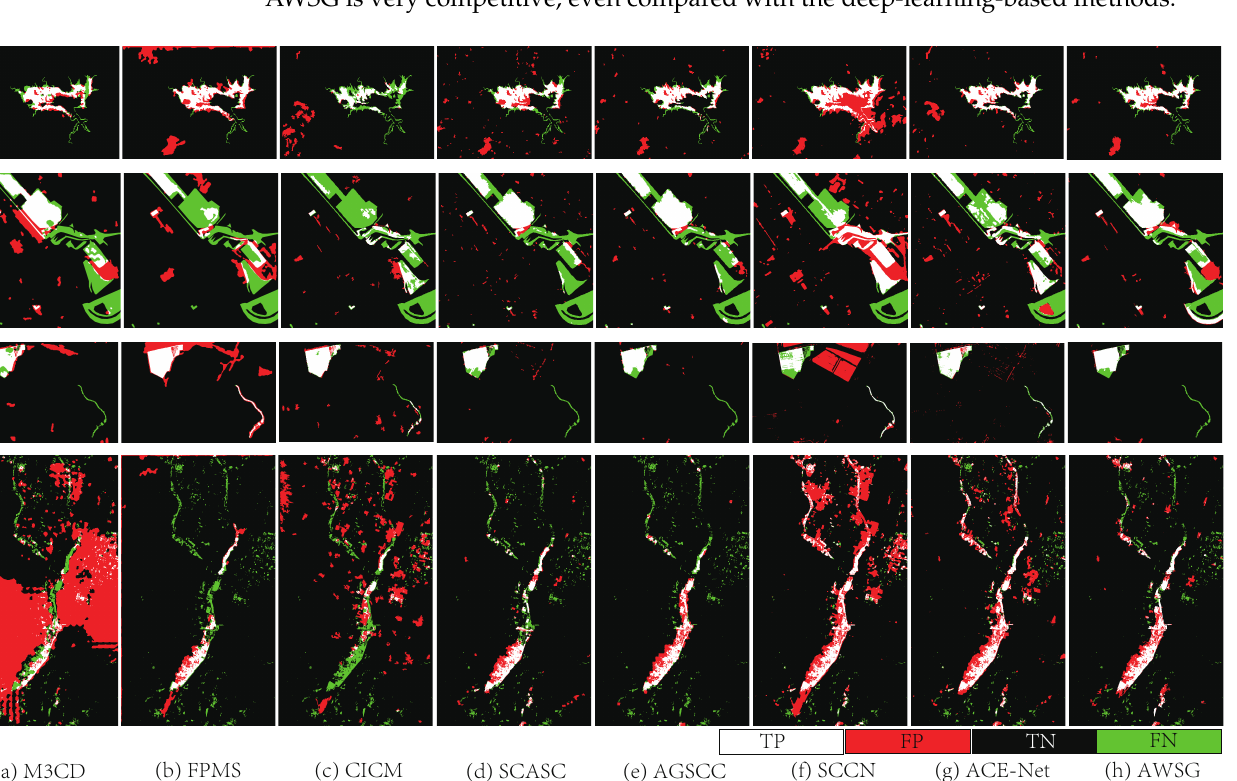
Figure 4. Binary CMs of different methods on heterogeneous datasets. From top to bottom, they correspond to Datasets #1 to #4, respectively. From left to right are binary CMs generated by: ( a ) M3CD; ( b ) FPMS; ( c ) CICM; ( d ) SCASC; ( e ) AGSCC; ( f ) SCCN; ( g ) ACE-Net; ( h ) AWSG. In the binary CM, White: true positives (TP); Red: false positives (FP); Black: true negatives (TN); Green: false negatives